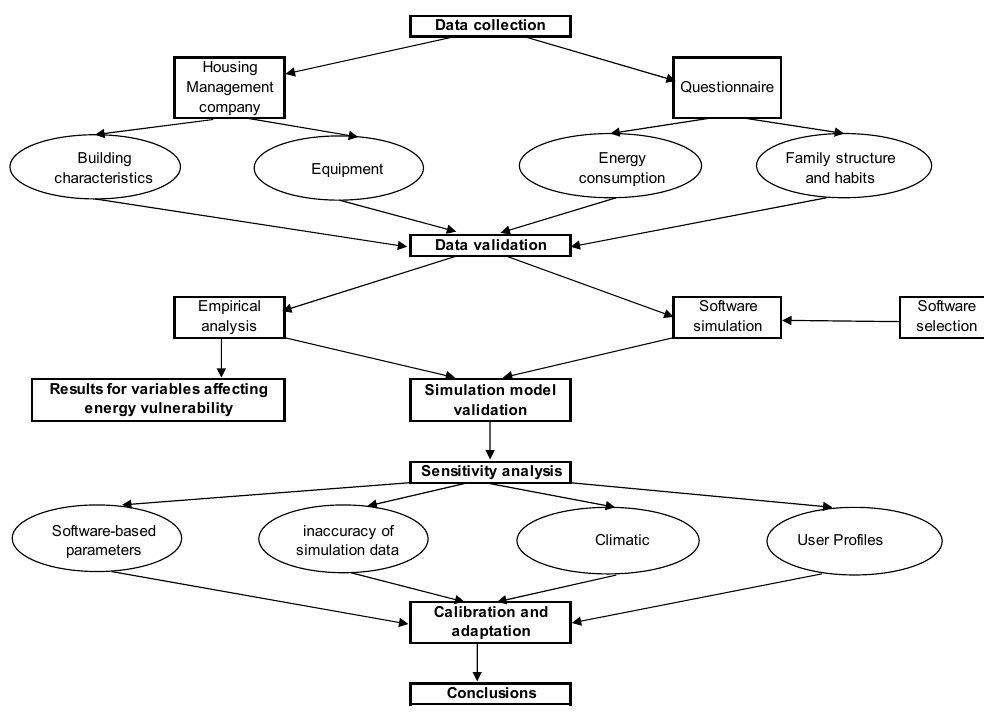
Figure 1. Flow chart depicting the buildings’ energy performance methodology.